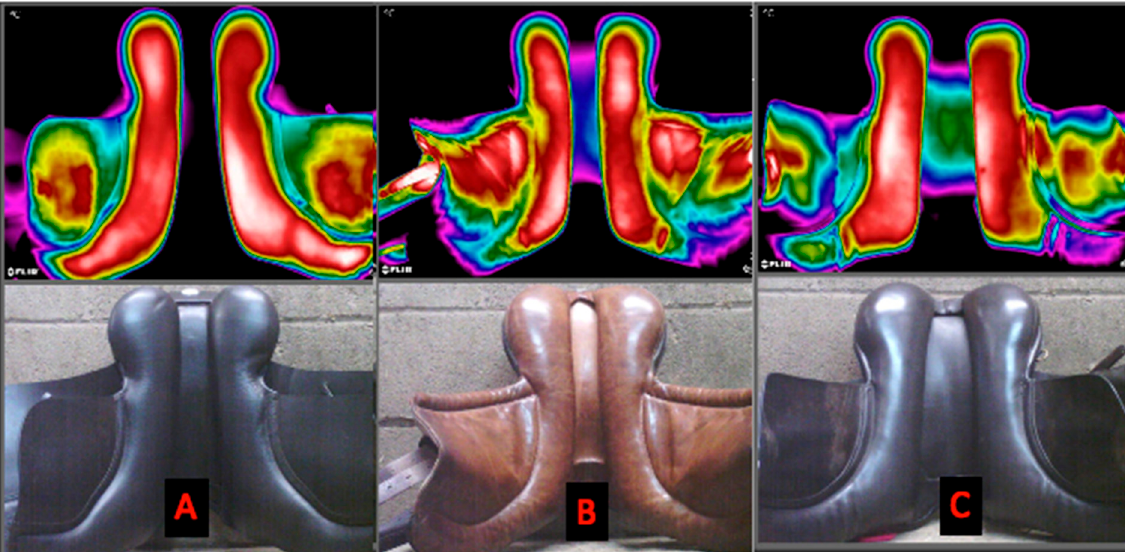
Figure 4. Illustrating thermograms of the ventral aspect of the saddle. ( A ) = correct saddle width, ( B ) = narrow saddle width and ( C ) = wide saddle width. Thermographs taken from three horses who had the highest mean and peak saddle pressures (kPa) during the standardised ridden exercise test. For saddle fit fixed factor: differences were found for the minimum temperatures for the cranial region (Figure 2) ( p = 0.04). Differences were found in the asymmetry of the maximum temperatures (°C) for the cranial region with an increase in asymmetry between the left and right cranial regions (Figure 3), for the correct saddle width (0.8 ± 0.7) compared to the narrow saddle width (0.1 ± 0.1, p = 0.03). No differences were found for the remaining parameters ( p > 0.06). Table 2. Minimum, maximum and mean thermal temperatures of the underside of the saddle.